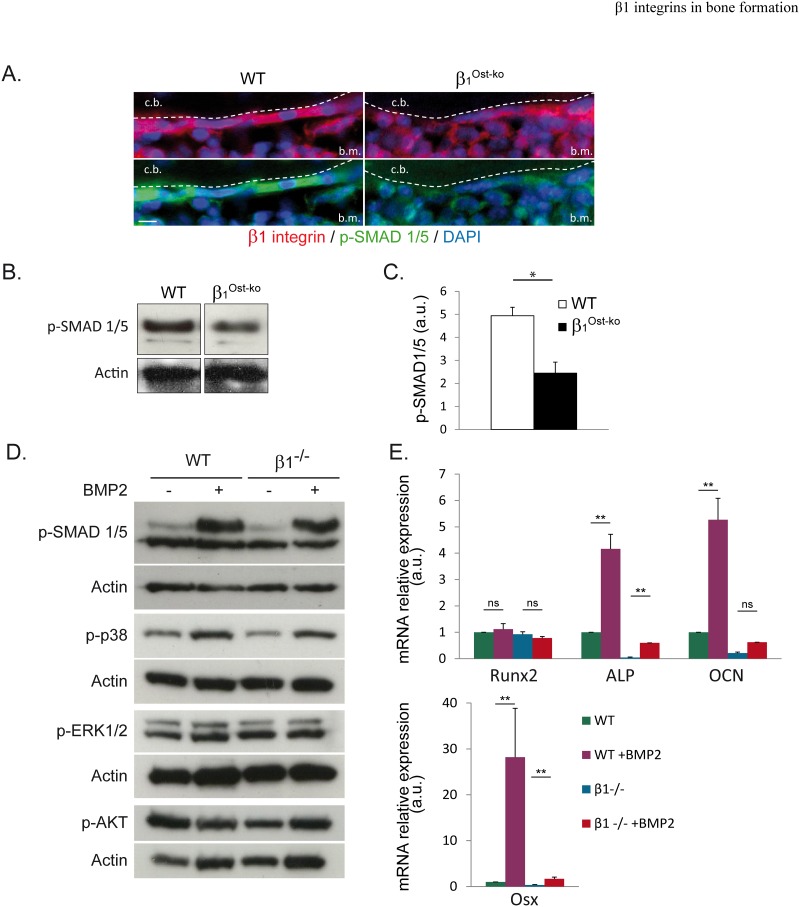
β1 integrins are essential for Smad1/5 phosphorylation in vivo, but controls the expression of BMP2 targeted genes regardless of Smad1/5 phosphorylation ex vivo.A. Immunofluorescence analysis of β1 integrins as well as Smad1/5 phosphorylation (P-Smad1/5) on wild-type and β1Ost-ko P4 mice sections (c.b.: cortical bone; b.m.: bone marrow; scale bar represents 10μm). Note the almost absence of Smad1/5 phosphorylation in the lack of β1 integrins. B and C. Western-blot analysis and quantification of Smad1/5 phosphorylation in long bones lysates from wt and β1Ost-ko P30 mice. Smad1/5 phosphorylation was normalized with actin (*: p<0.05). D. Western-blot analysis of Smad1/5, p38, ERK1/2 and AKT phosphorylation in immortalized WT and β1-/- osteoblasts cultures treated or not with BMP2. E. Quantitative PCR analyses of BMP2-independent Runx2, or BMP2-dependent Alkaline Phosphatase (ALP), Osteocalcin (OCN) and Osterix (Osx) mRNA expression levels in WT or β1-/- osteoblasts cultures treated or not with BMP2 (*: p<0.005). Note the absence of induction by BMP2 of target genes in β1-/- osteoblasts.